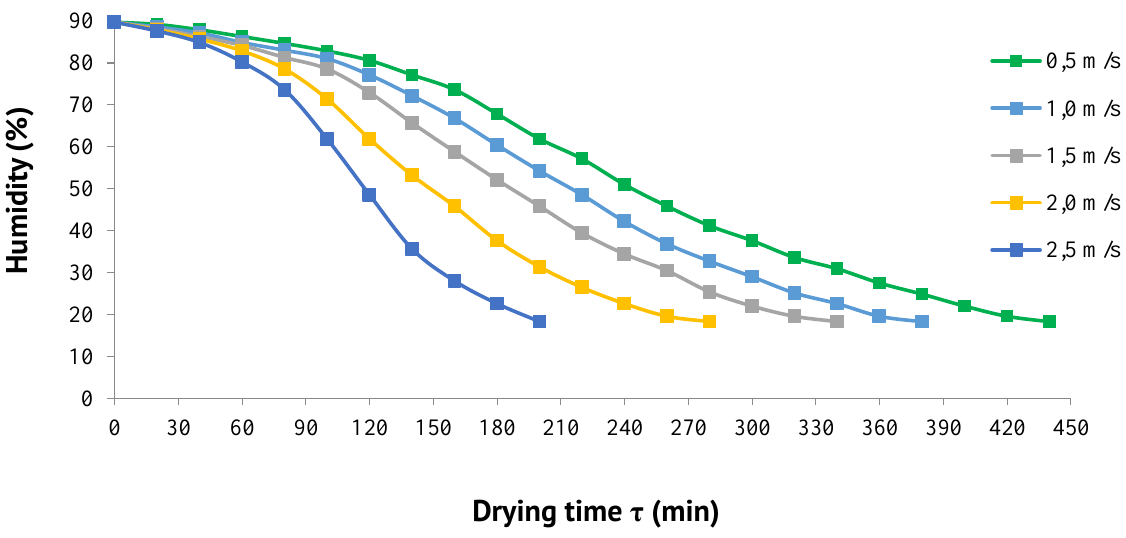
Figure 8. Peaches different thermal agent velocities drying curves (Thermal agent relative